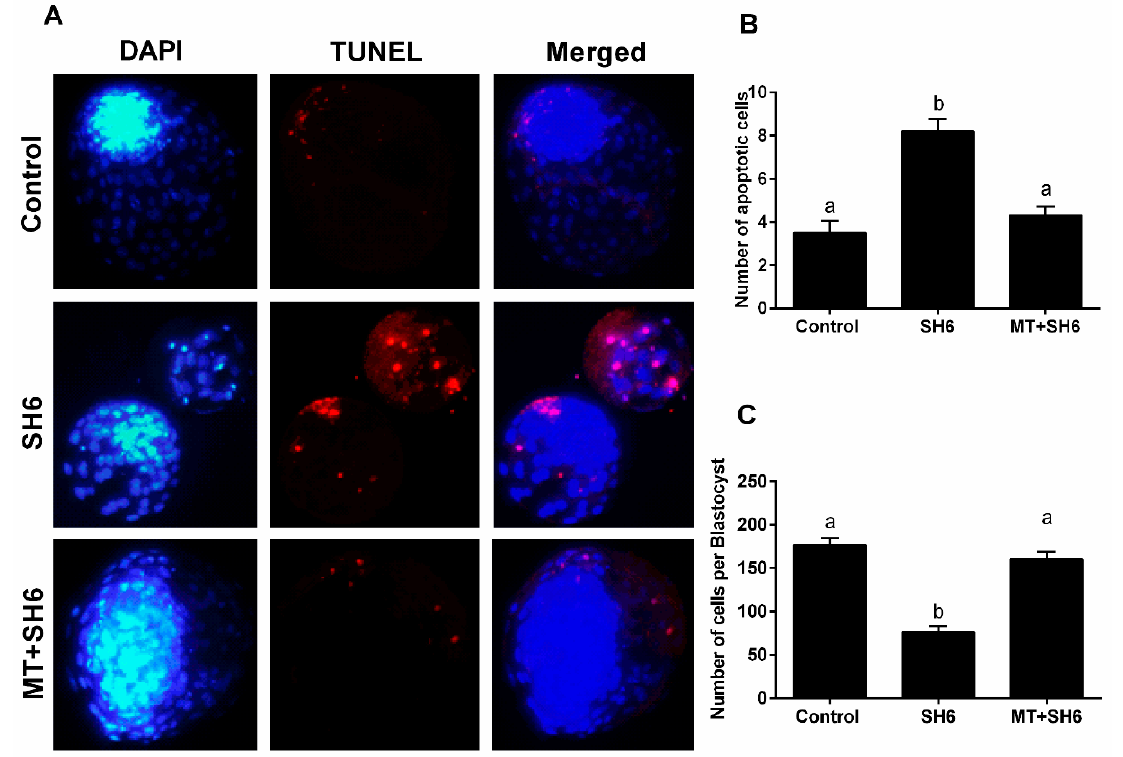
Figure 8. Effect of melatonin supplementation during SH6 exposure on the quality of embryos. ( A ) Nuclei were stained using DAPI while fragmented DNA was probed by TUNEL ( B ) Number of apoptotic cells per blastocyst; ( C ) Total number of cells per blastocyst. Values with different superscripts indicate significant differences ( p < 0.05). Original magnification 200×.